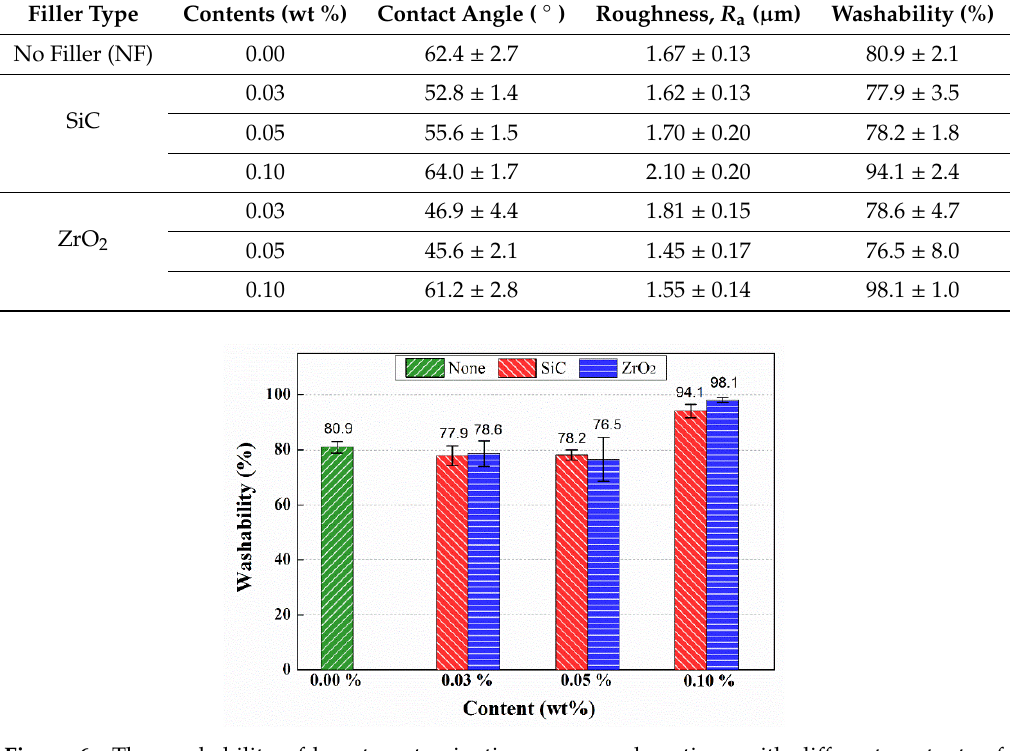
Figure 6. The washability of burnt contamination on enamel coatings with different contents of SiC/ZrO 2 fillers.